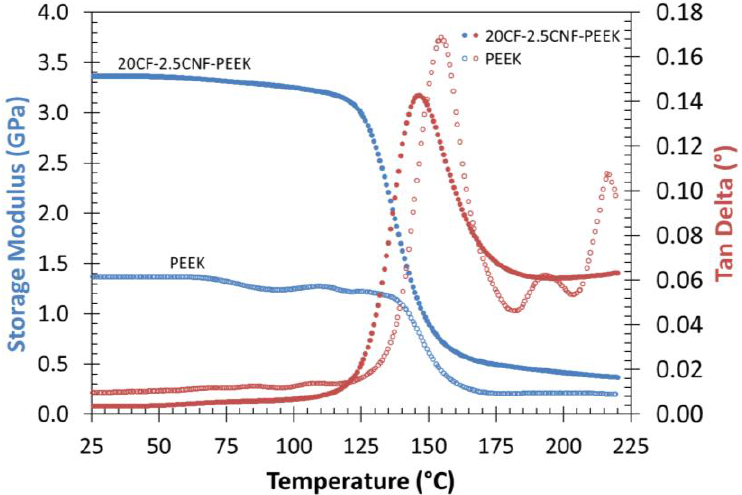
Figure 9. Dynamic mechanical torsion comparison for PEEK and 20CF–2.5CNF-PEEK.